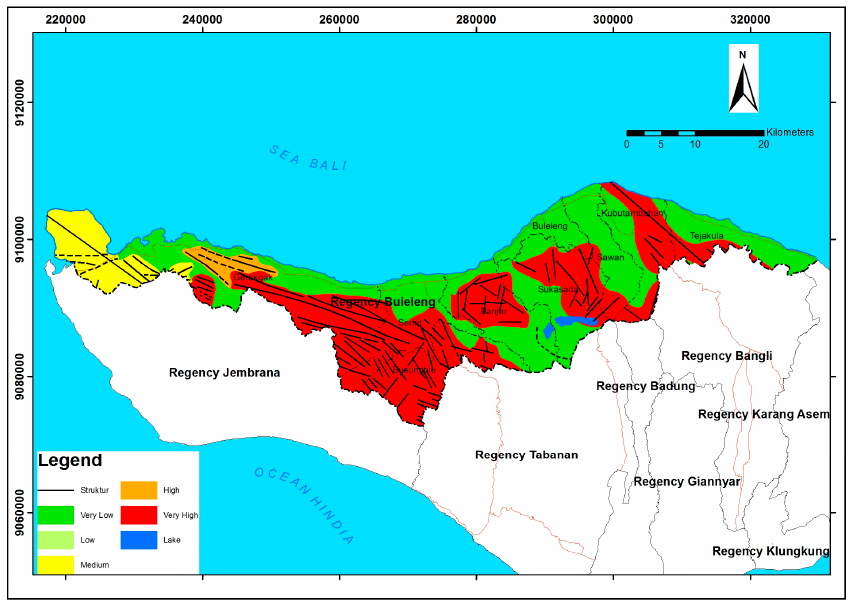
Figure 7. Geological structure on the study area.